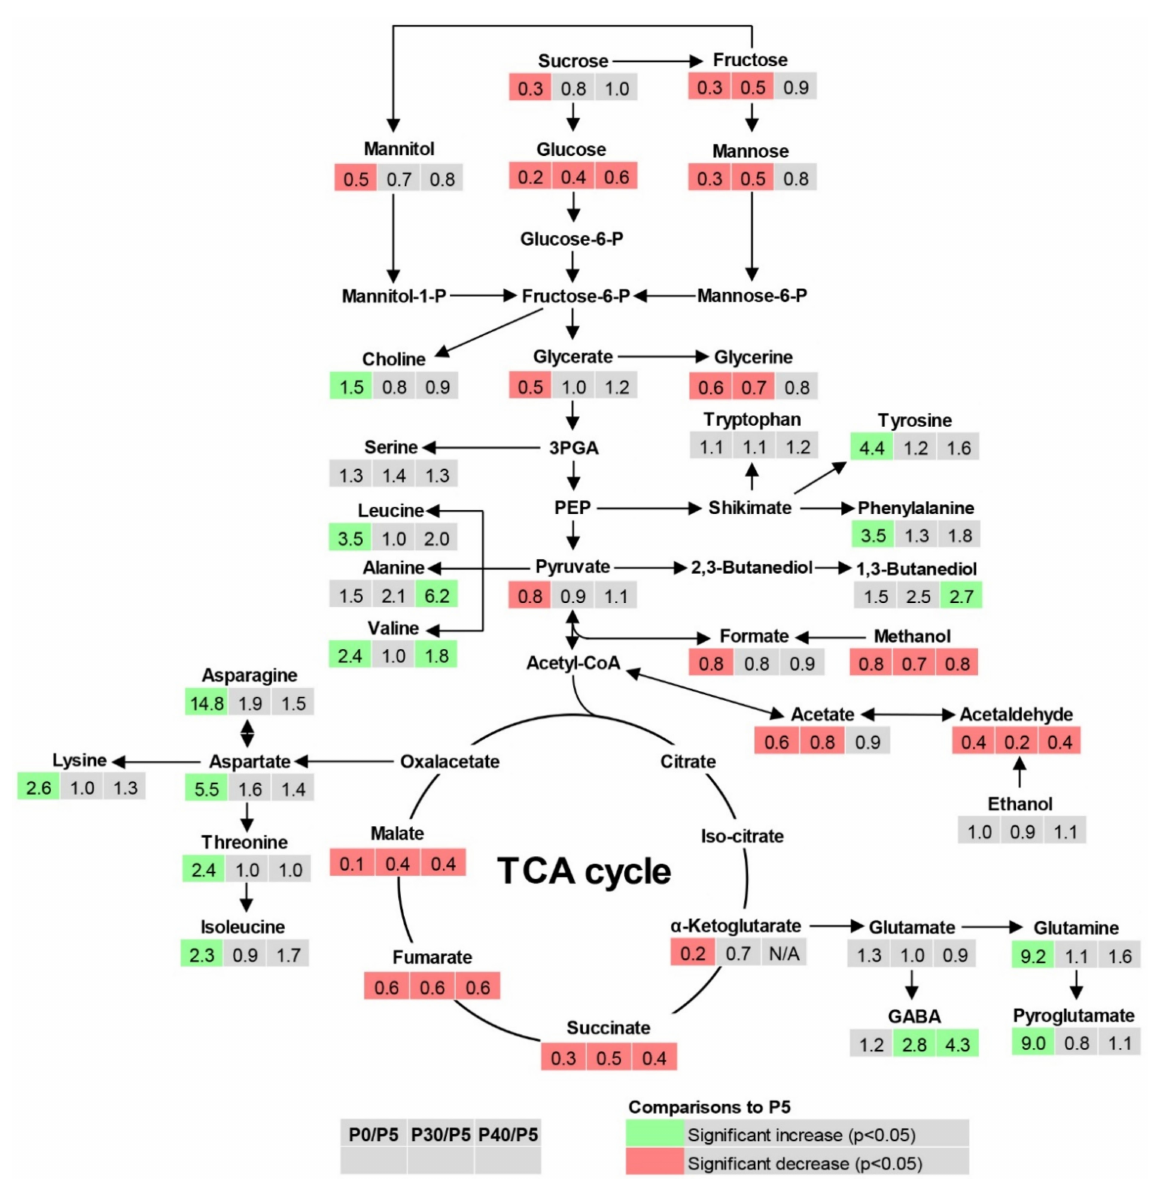
Figure 4. Effect of P deficiency and toxicity on metabolite concentration in roots of potato plants. The relative ratios were calculated by the division of metabolite concentration plant grown at P0, P30, and P40 with those at P5 as P sufficient treatment ( n = 4). Light green and red present the significant increase and decrease ( p ≤ 0.05), respectively. N/A = comparison not possible due to incomplete data; 3PGA = 3-phosphoglycerate; PEP = Phosphoenolpyruvate; Acetyl- CoA = Acetyl Coenzyme A; TCA = tricarboxylic acid; GABA = γ -aminobutyrate. Arrows with one direction show synthesis of a metabolite and arrows with double direction show reversible